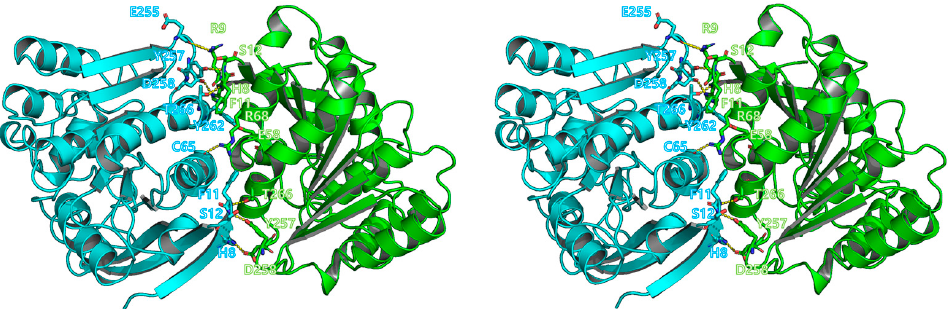
Figure 4. Dimerization of Burkholderiaceae sp. S-formylglutathione hydrolase ( Bu SFGH). The dimer interface in Bu SFGH is shown in stereo view and interface residues are marked using a stick model. Interactions are shown as yellow-dotted lines.